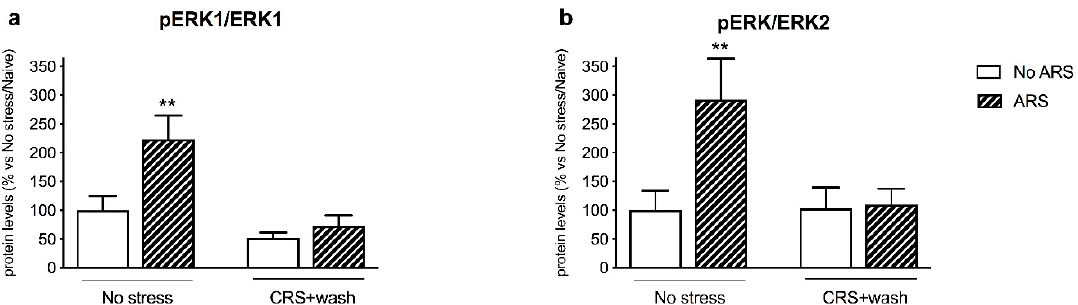
Figure 5. Analysis of ERK1/2 (panels a , b ) (phosphorylated and total) protein levels in the crude synaptosomal fraction of the prefrontal cortex of chronically stressed rats (CRS) exposed to an acute challenge (ARS) after 3 weeks of washout (wash). The data, expressed as a percent change of No stress/Naïve animals, are the mean ± SEM. ** p < 0.01 vs. No stress/No ARS (two-way ANOVA with PLSD).